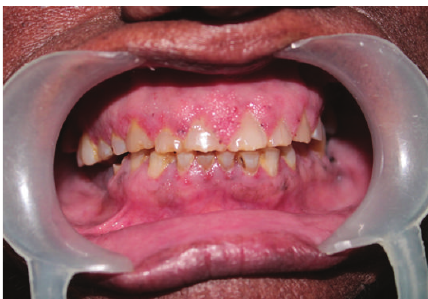
Figure 3: Multiple coalescent papillary projections involving upper and lower anterior gingiva.